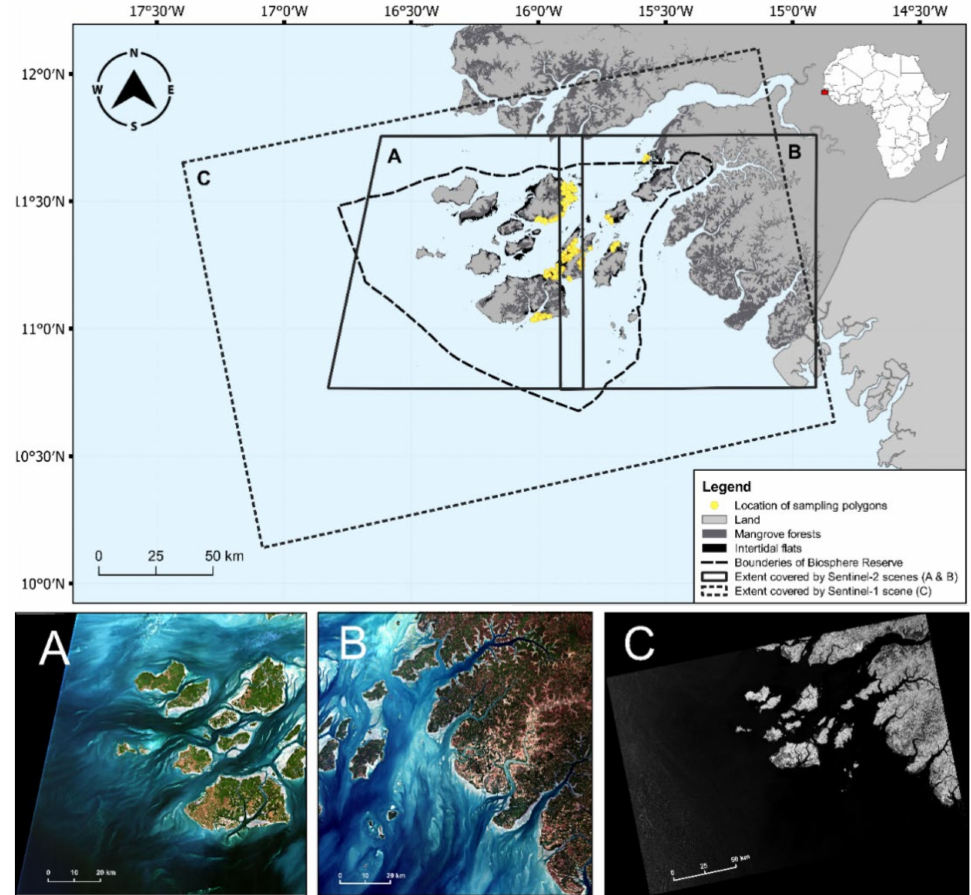
Figure 1. Map of study area, in the Bijag ó s Archipelago, showing the location of the sampling polygons used for field reference data collection, the limits of the Biosphere Reserve, and the extent covered by each satellite scene used in this study. ( A , B ) show RGB images of Sentinel-2 scenes using red, green, and blue bands; ( C ) shows a grey-scale RGB composite with two channels of Sentinel-1 VH and VV